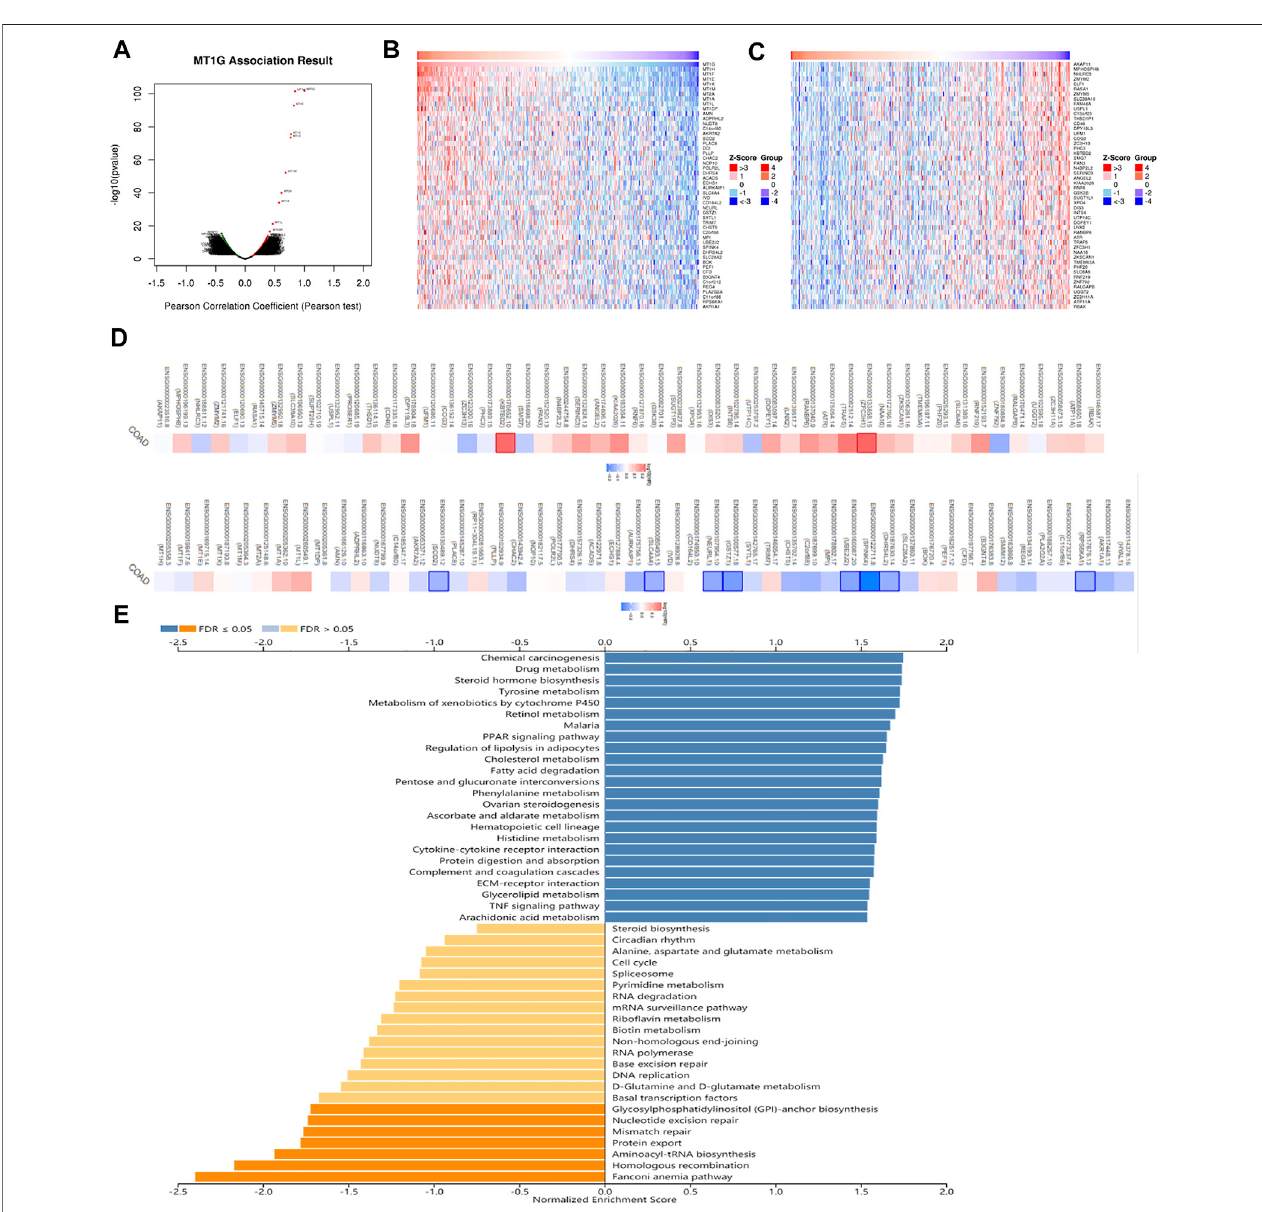
FIGURE5| Co-expression analysisofMT1GinCRC. (A) Genesremarkably related toMT1GbyPearson ’ stest. (B,C) Heatmap indicatedthetop50positivelyand negativelyco-expressedgenesofMT1G. (D) Survivalmapofthetop50positivelyornegatively co-expressedgenesofMT1G. (E) GSEAanalysesindicatedthepotential signaling pathways regulated by